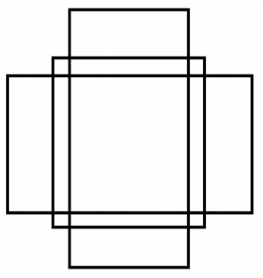
Figure 3. Three ratios of same size